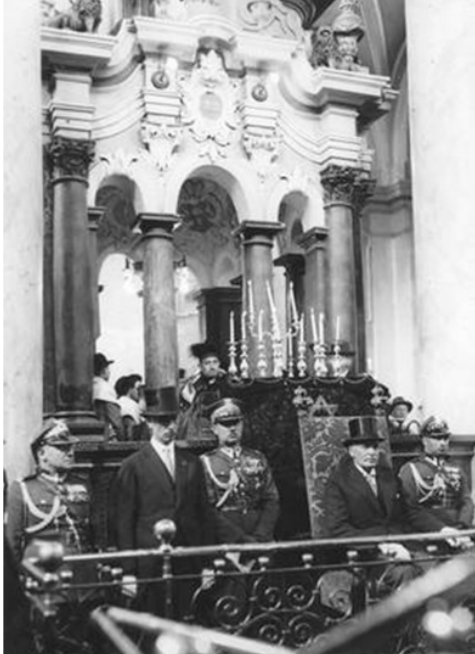
Figure 6. President Ignacy Mo ś cicki of Poland seated in front of the bimah in 1930. Photo: National Digital Archives of Poland, www.szukajwarchiwach.gov.pl/jednostka/-/jednostka/5965807/obiekty/ 367856#opis_obiektu. Public domain